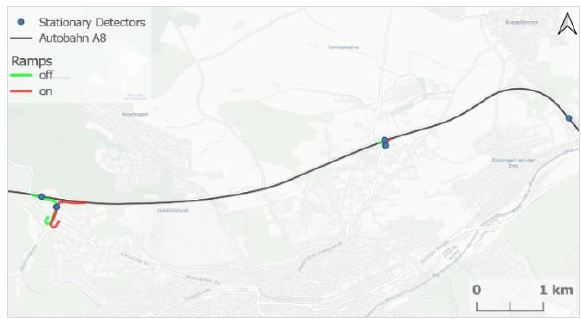
Figure 3: Stationary cross-sectional measurement stations.